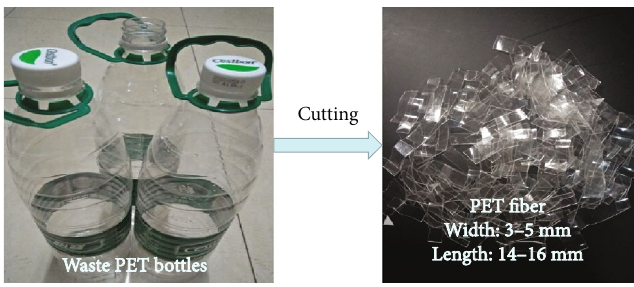
Figure 2: Cutting PET bottles for PET fi ber.